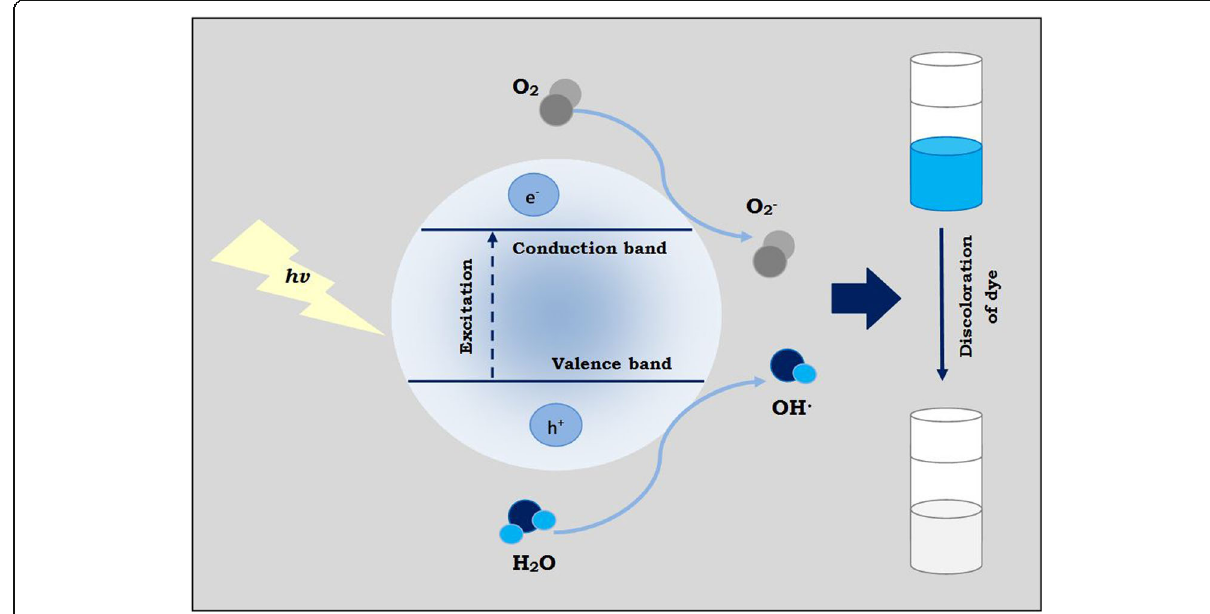
Fig. 4 Nanoparticles assisted photocatalysis and discoloration of